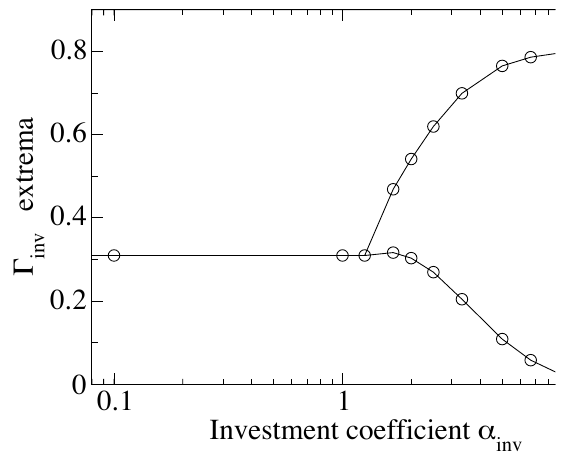
Fig. 12. Bifurcation diagram for the Non-Equilibrium Dynamic Model (NEDyM) of Hallegatte et al. (2008). The abscissa dis- plays the values of the control parameter α inv , while the ordinate displays the the corresponding values of the investment ratio 0 inv . The model has a unique, stable equilibrium for low α inv values, α inv ≤ α 0 = 1 . 39. For higher values, a Hopf bifurcation at α 0 leads to a limit cycle whose minimum and maximum values are shown in the figure. Transition to chaotic, irregular behavior occurs for even higher values (not shown). From Hallegatte et al. (2008).